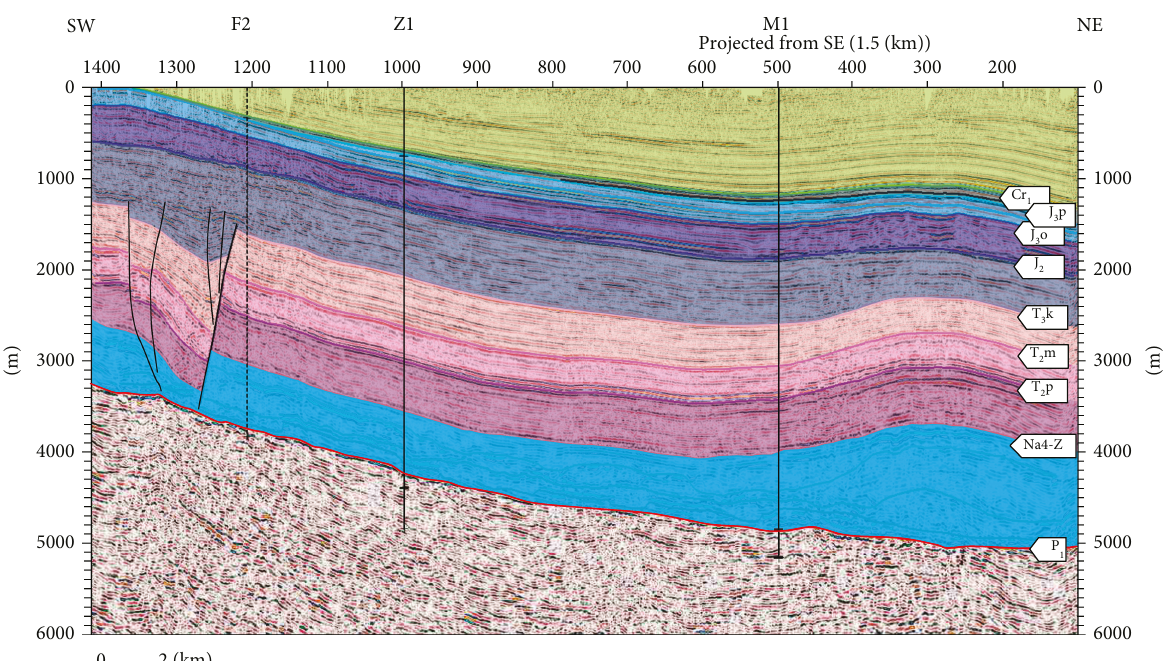
Figure 5: Results of structural interpretation of seismic depth section located close to the wells (red line in Figure 3). Explanations of seismic : bottom surface of the Upper Cretaceous/top surface of the Lower Cretaceous; J horizons: Cr 1 top surface of the Upper Jurassic (Oxfordian); J Muschelkalk; T p: top surface of the Middle Bunter Sandstone; Na4-Z: top surface of the Zechstein; P 2 surface of the Lower